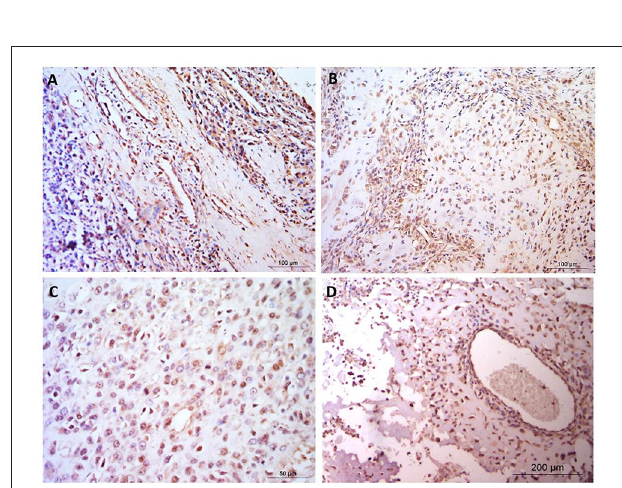
FIGURE 3 | Osteosarcoma immunohistochemical staining for MMP3. (A–D) MMP3 positive staining in blood vessels, cytoplasm and nuclei but negative staining in the osteoid, in four canine osteosarcoma samples. Scale bars represent (A, B) 100 µ m, (C) 50 µ m, and (D) 200 µ